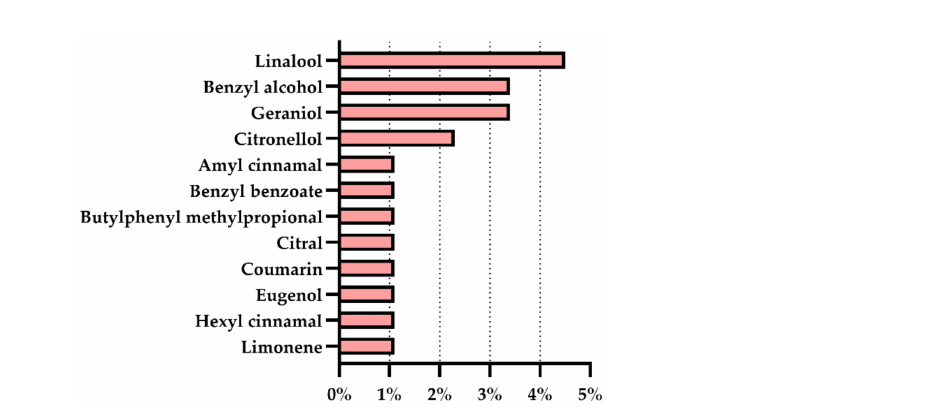
Figure 2. Prevalence of the fragrance allergens regulated in Europe in products for sensitive skin.